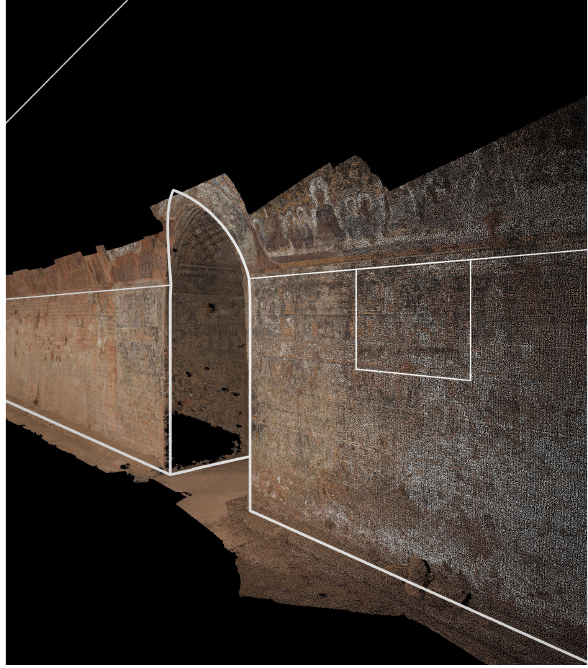
Figure 12. Photogrammetry point cloud in BIM of west wall painting.